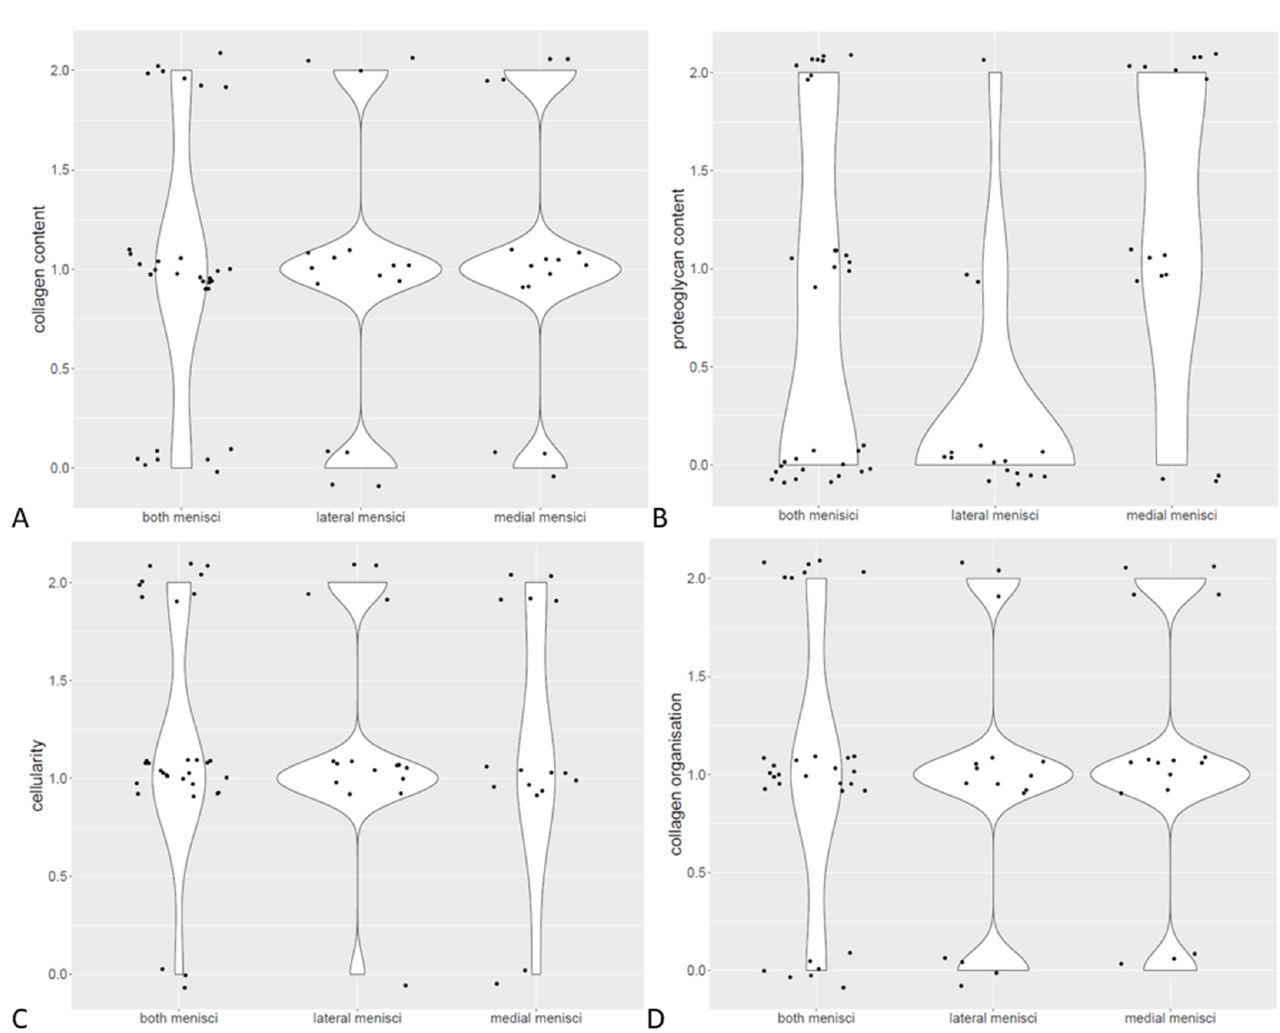
Figure 5. Scoring of collagen content showed no significant differences between medial and lateral menisci ( A ). Scoring of proteoglycan content showed a higher score in lateral menisci ( B ). Scoring of cellularity showed no significant differences between medial and lateral menisci ( C ). Scoring of collagen organization showed no significant differences between medial and lateral menisci ( D ).